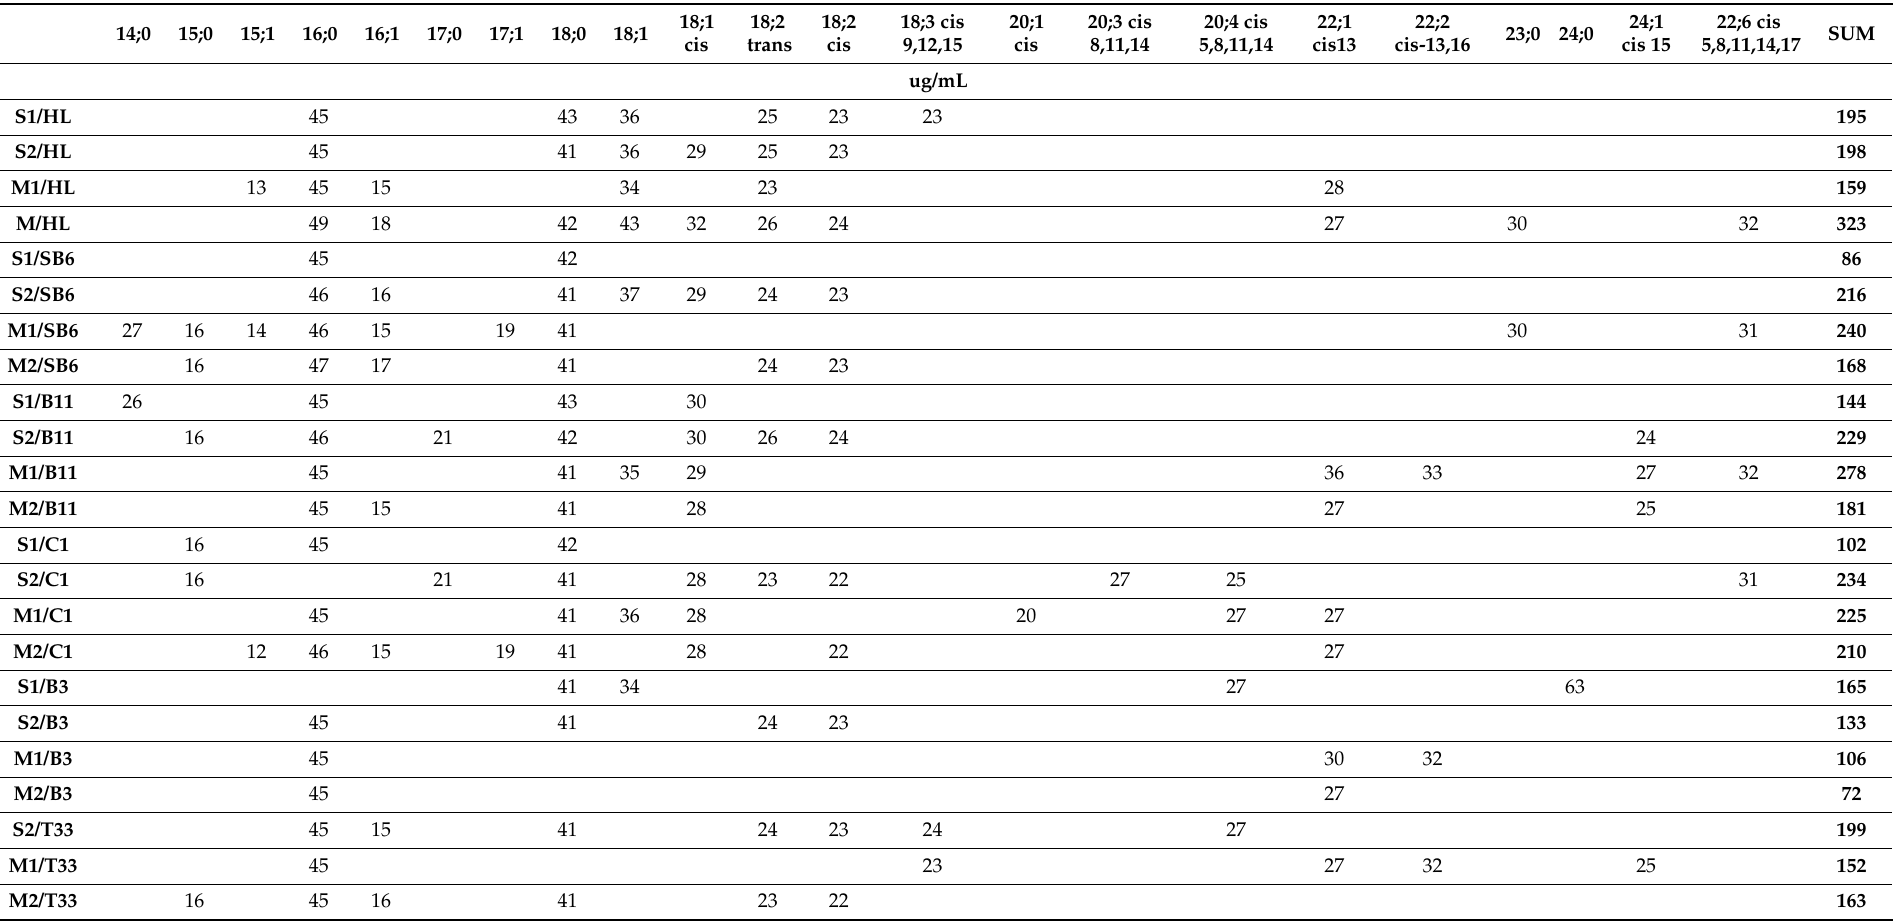
Table 3. Result of gas chromatography—types of bonds and amounts of fatty acids ( µ g/mL); cultures of T. citrinoviride HL, C1, B3, B11; T. atroviride SB6, T. reesei QM9414 and T. harzianum T33 in Saunders (S1, S2) and MGP (M1, M2)